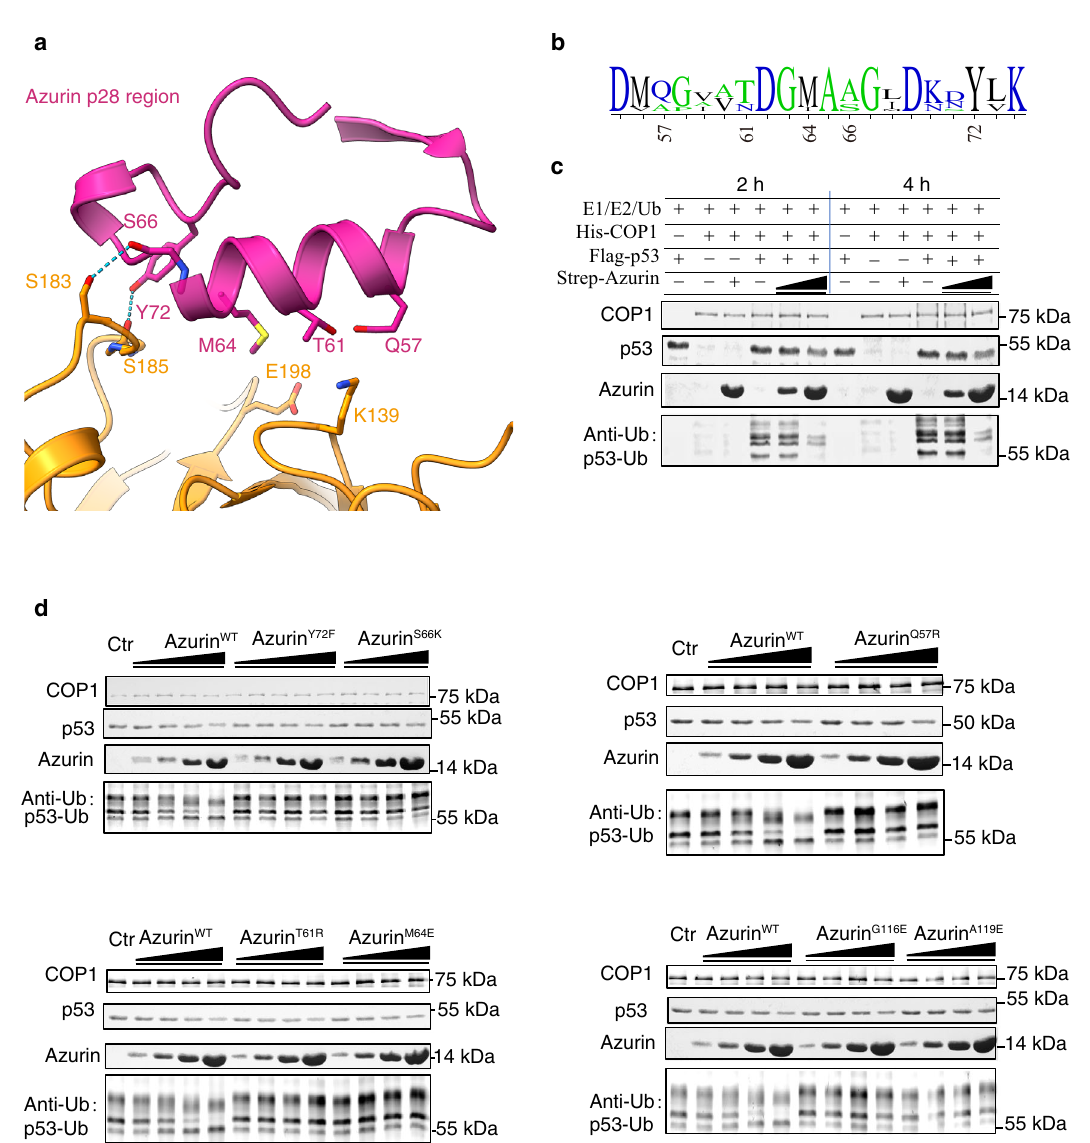
Fig. 3 Dissection of the effect of azurin on p53 ubiquitination. a Highlighting the detailed interaction of azurin p28 region and p53-DBD. Residues involved in binding are labeled and shown as sticks. b Sequence conservation of residues at azurin p28 region involved in p53 binding. c In vitro ubiquitination assay of COP1-mediated p53 ubiquitination intervened by azurin. The reaction mixtures were incubated for 2 and 4 h, and then resolved by SDS-PAGE and immunoblotting assay with exclusive antibodies. d Effect of the af fi nity-disrupting mutants on ubiquitination level of p53 measured by ubiquitination assay. The designed mutants are azurin Q57R, T61R, M64E, G116E and A119E. Ctr represents p53 ubiquitination without any azurin